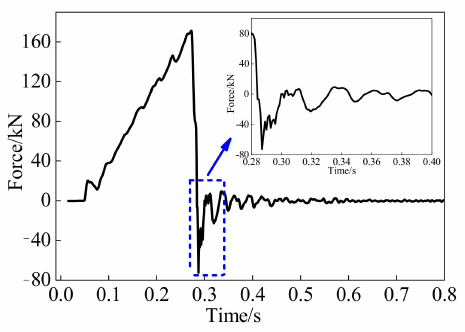
Figure 3. Free vibration of test system after a specimen fractured.